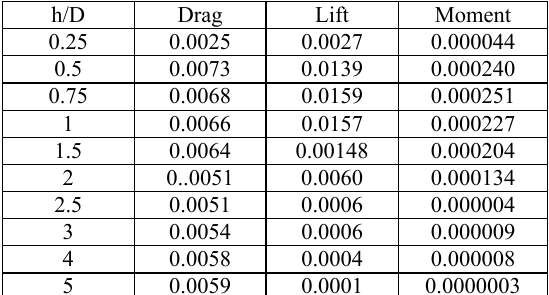
Table 3: Computed aerodynamic coefficients from h/D = 0.25 to 5 h/D Drag